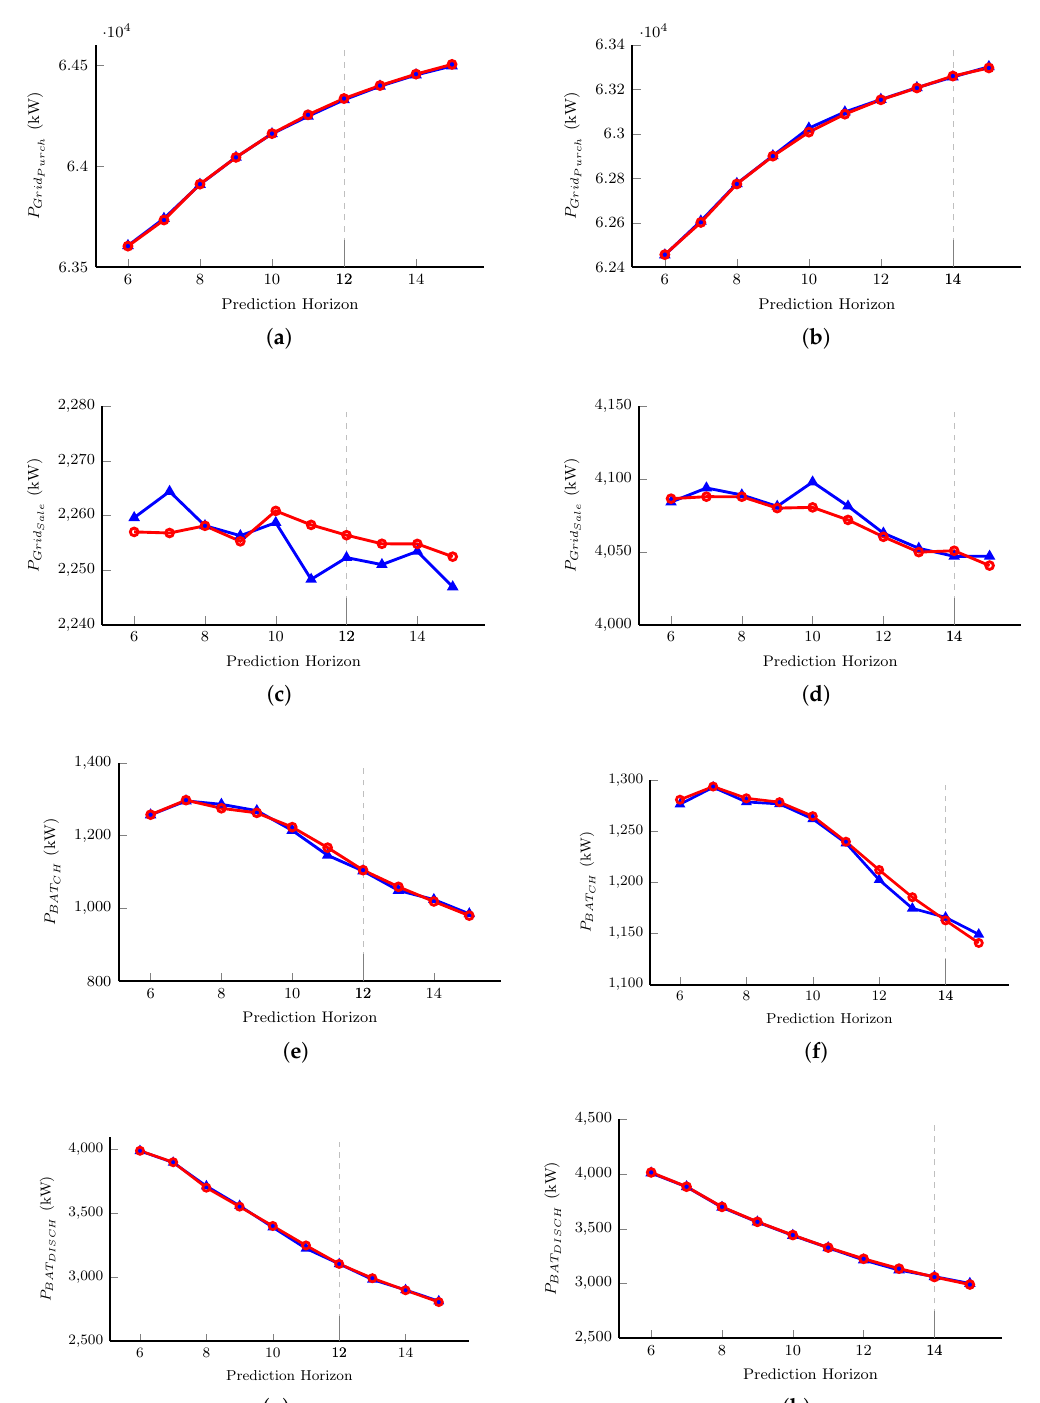
Figure 13. Total energy (kW) used on a sunny day ( a , c , e , g ) and a day with passing clouds ( b , d , f , h ) where ( ) is Scenario 2 and ( ) is Scenario